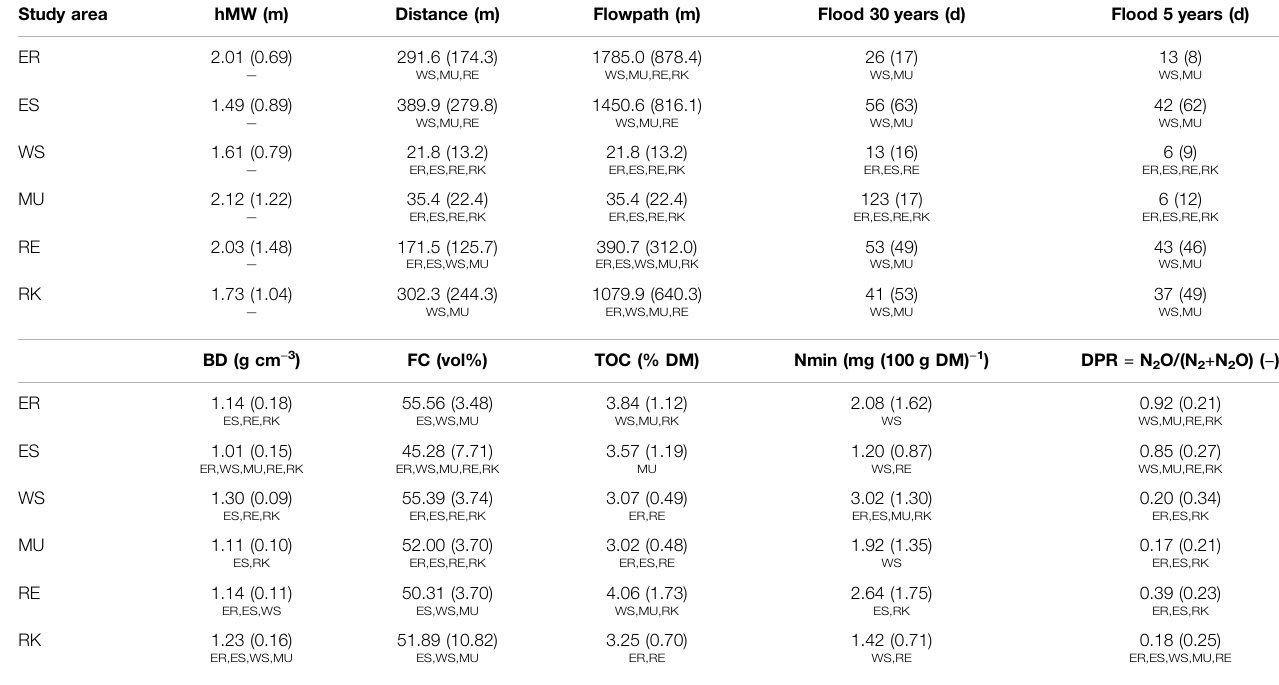
TABLE2| Measuredaverage,standarddeviation(inparenthesis),andsigni fi cantdifferencesbetweenallplotsineachofthestudyareas:Elbe_R(ER),Elbe_S(ES),Weser_S (WS), Main_U (MU), Rhine_E (RE), Rhine_K (RK) (superscripted, Mann Whitney U test, p < 0.05, n studyarea (cid:2) 15 – 20, n total (cid:2) 105) of hydrological parameters height above mean water (hMW), distance to riverbank (distance), hydrological distance ( fl owpath), average yearly inundation duration ( fl ood) on the basis of 30 years (30 years) and 5 years(5 years)andsoilparameterssoilbulkdensity(BD), fi eldcapacity(FC),totalorganiccarbon(TOC),mineralnitrogencontent(Nmin)andthedenitri fi cationproductratio (DPR (cid:2) N 2 O/(N 2 +N 2 O) (cid:2) DP N2O /DP). Signi fi cant differences (Mann Whitney U test, p < 0.05) of fl ood 5 years compared to fl ood 30 years are printed in